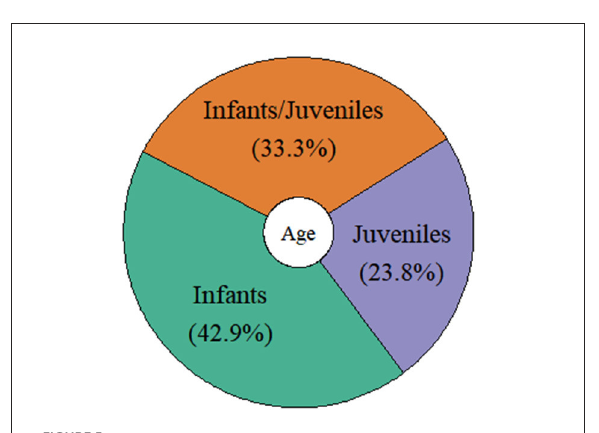
FIGURE5 Different age classes investigated in the reviewed studies.